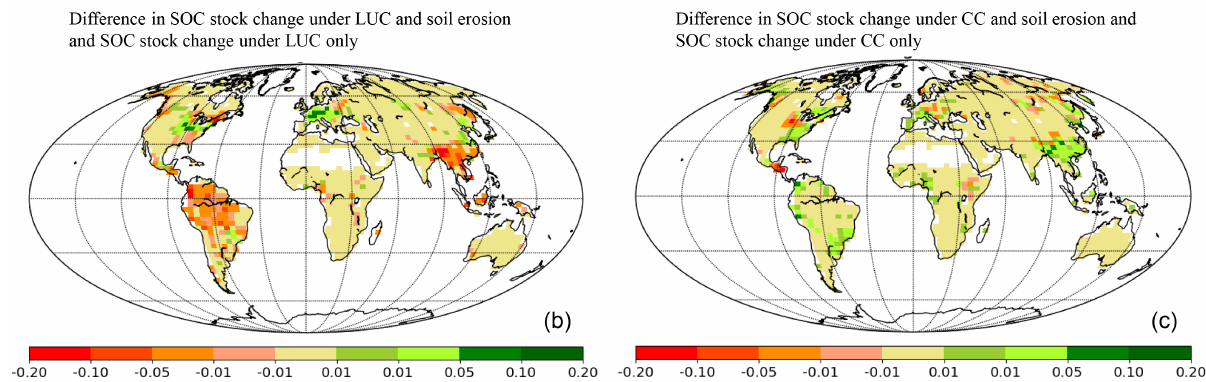
the soil by litter fall due to harvest and a lower